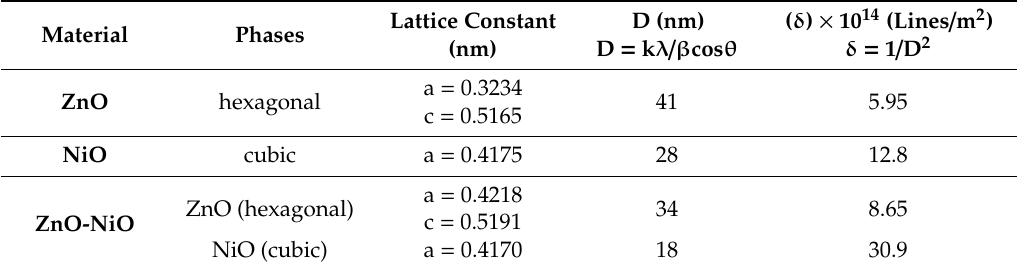
Figure 1. XRD pattern of ZnO, NiO nanoparticles and ZnO-NiO nanocomposite. Table 1. Physical parameters calculated from XRD data of nanocomposite.